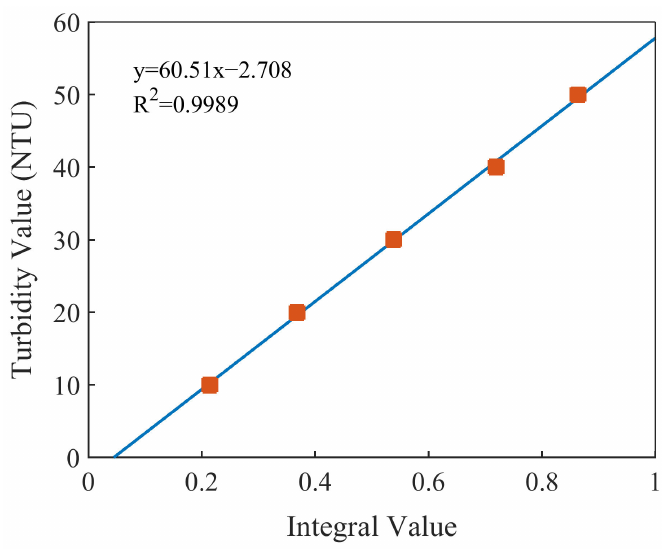
Figure 5. Fitting relationship between the integral values and the turbidity